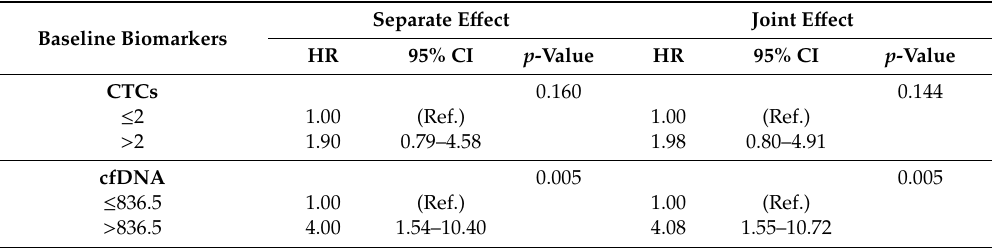
Table 4. Separate and joint e ff ects of baseline CTCs and cfDNA on OS of progressing patients estimated through the Cox regression modeling.